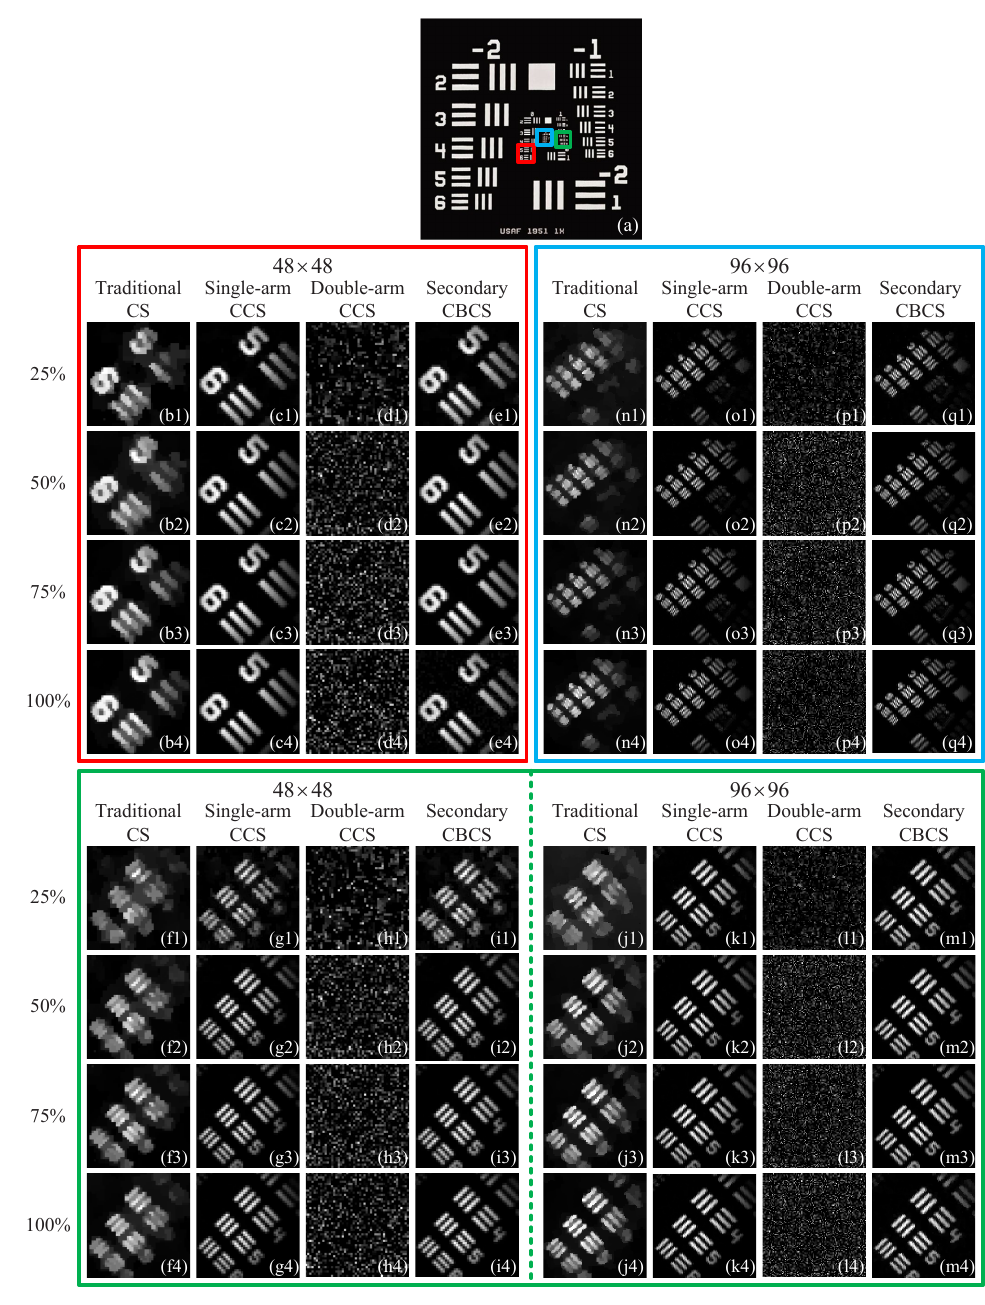
Figure 8. Reconstructed results of four CS schemes for different regions of the resolution test chart with different sampling rates. ( a ) gives three imaging regions in the resolution test chart successively marked with red, green and blue boxes. ( b1 – e4 ) are the recovered images of the region inside the red box of ( a ) with modulated patterns of 48 × 48 pixel-units by using four CS schemes, respectively. ( f1 – m4 ) are the restored images of the region within the green box of ( a ) with modulated patterns